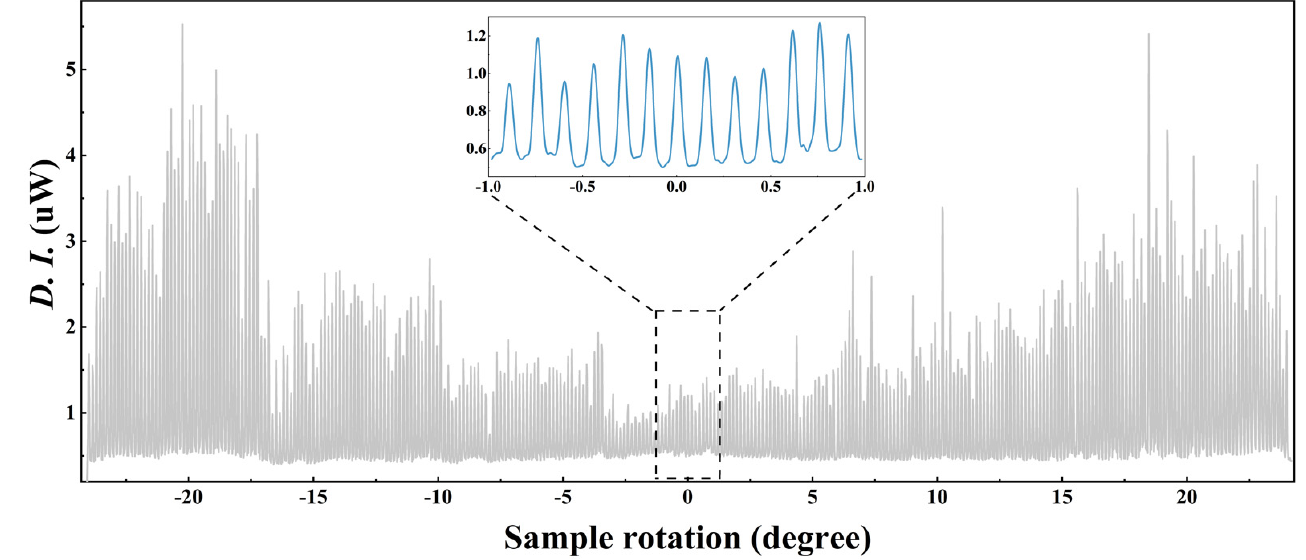
Figure 2. The multiplexing of 321 weak holograms within the C 60 -PQ/PMMA photopolymer [46] .